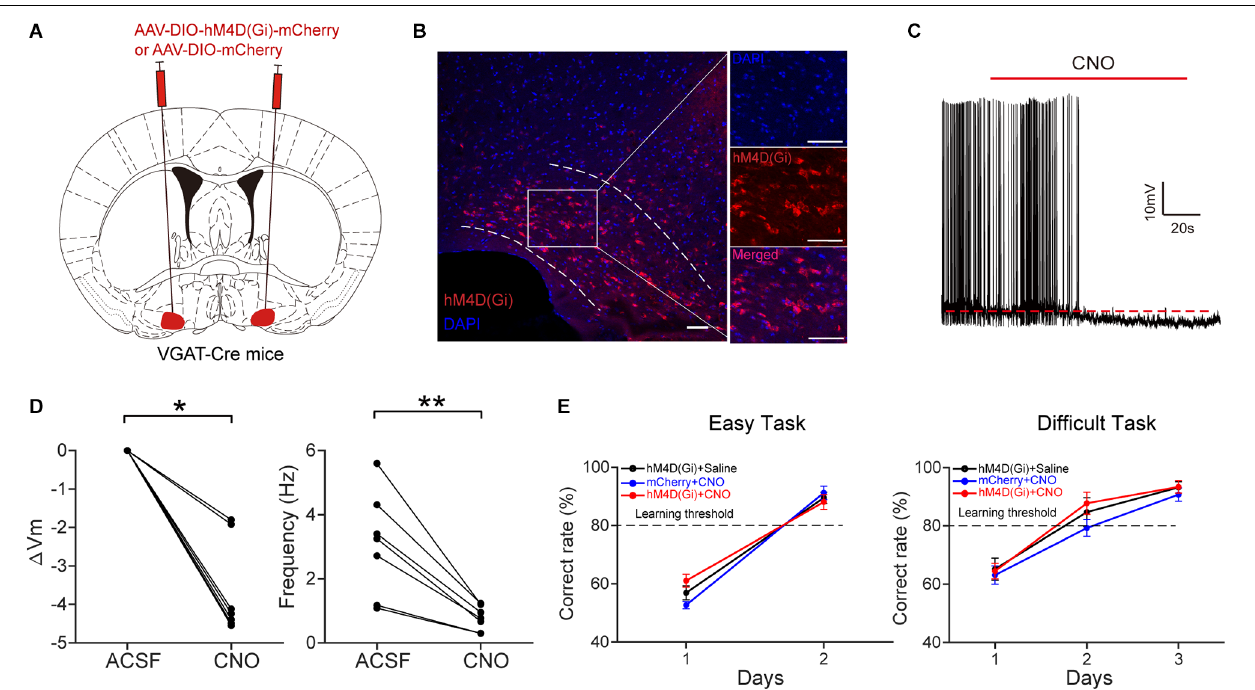
FIGURE 8 | Chemogenetic inactivation of HDB GABAergic neurons has no effect on odor discrimination. (A) Schematic of virus injection. AAV-DIO-hM4D(Gi)-mCherry/AAV-DIO-mCherry was injected into bilateral HDB of VGAT-Cre mice. (B) Expression of hM4D(Gi)-mCherry in HDB GABAergic neurons. Scale bar: 50 µ m. (C) A representative trace recorded from a current-clamped neuron expressing hM4D(Gi). (D) Comparison of the change in membrane potential ( ∆ V m ) and frequency of action potentials before and after the application of CNO (Left: Wilcoxon’s sign rank test, z = 2.366, P = 0.018; Right: paired t -test, t (6) = 4.8145, P = 0.003, n = 7 cells from four mice). (E) Comparison of odor discrimination performance between control (black, n = 8 mice; blue, n = 6 mice) and experimental (red, n = 9 mice) mice during the easy task (left) and the difficult task (right) (two-way ANOVA, Easy task: F (2,44) = 0.62, P = 0.54; Difficult task: F (2,67) = 1.39, P = 0.26). * P < 0.05, ** P <